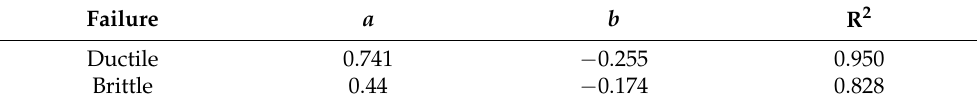
Figure 8. Less than 2% of HPZs located in NCA. ( a ) k t is 3 and V load is 1 mm/s; ( b ) k t is 2 and V load is 15 mm/s. Table 3. The fitting